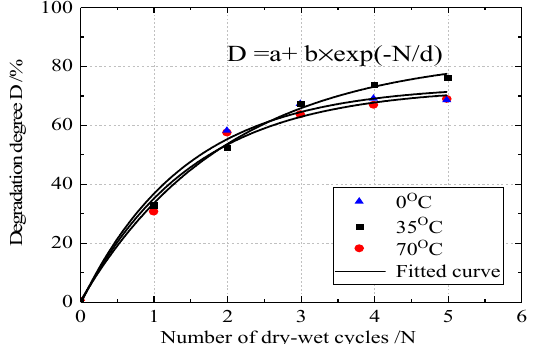
Figure 9. Degradation of cohesion under dry–wet cycling.